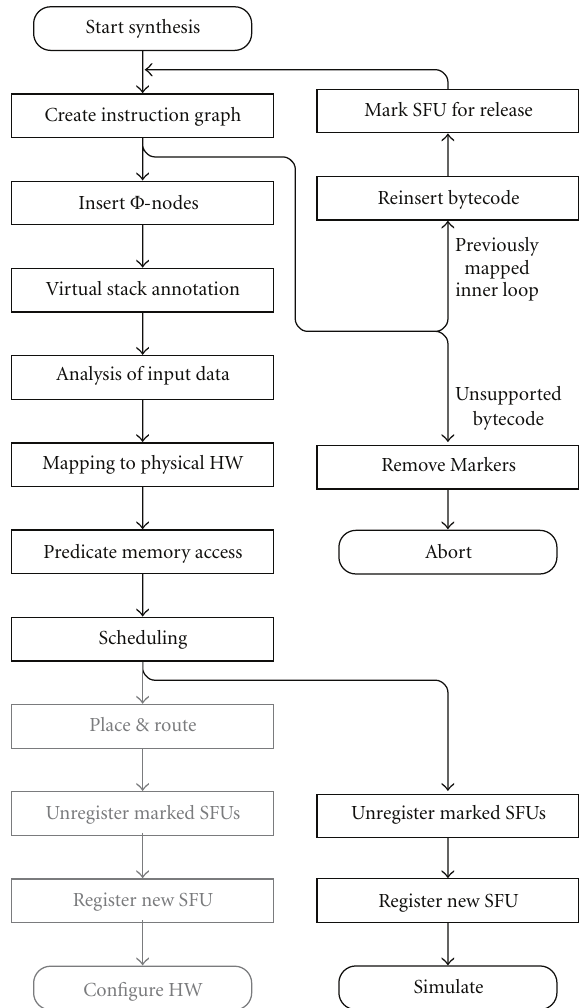
Figure 5: Overview of synthesis